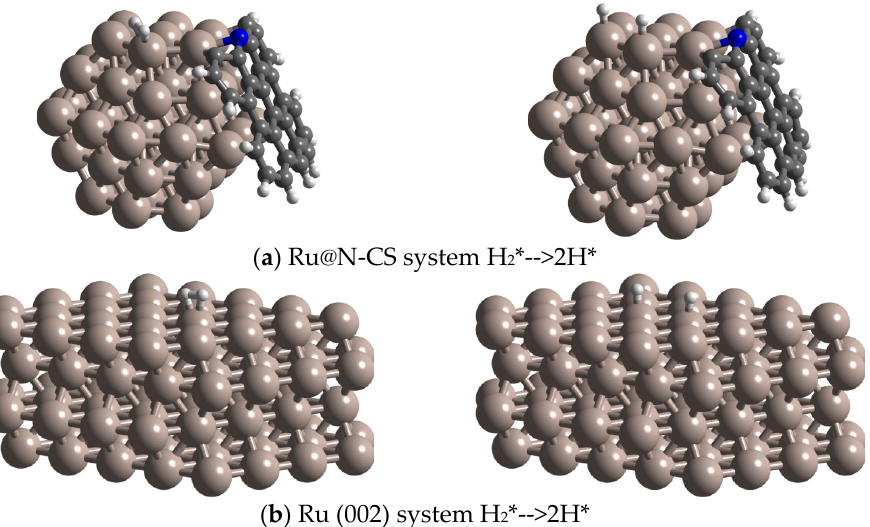
Figure 4. The optimized structures of ( a ) Ru@N-CS system H 2 *–>2H*, ( b ) Ru (002) surface H 2 *–>2H*. Table 1. The calculated H 2 decomposition energy barrier (eV) on Ru@N-CS and Ru (002). Ru@N-CS Ru